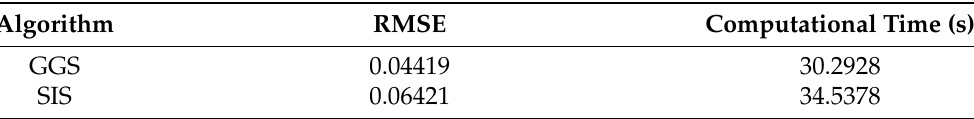
Figure 9. The value of log-likelihood ( top ) and the number of cuts ( bottom ) for the first 1000 iterations (Example 2). Table 2. The average running time and root mean square for the GGS and the SIS algorithms.